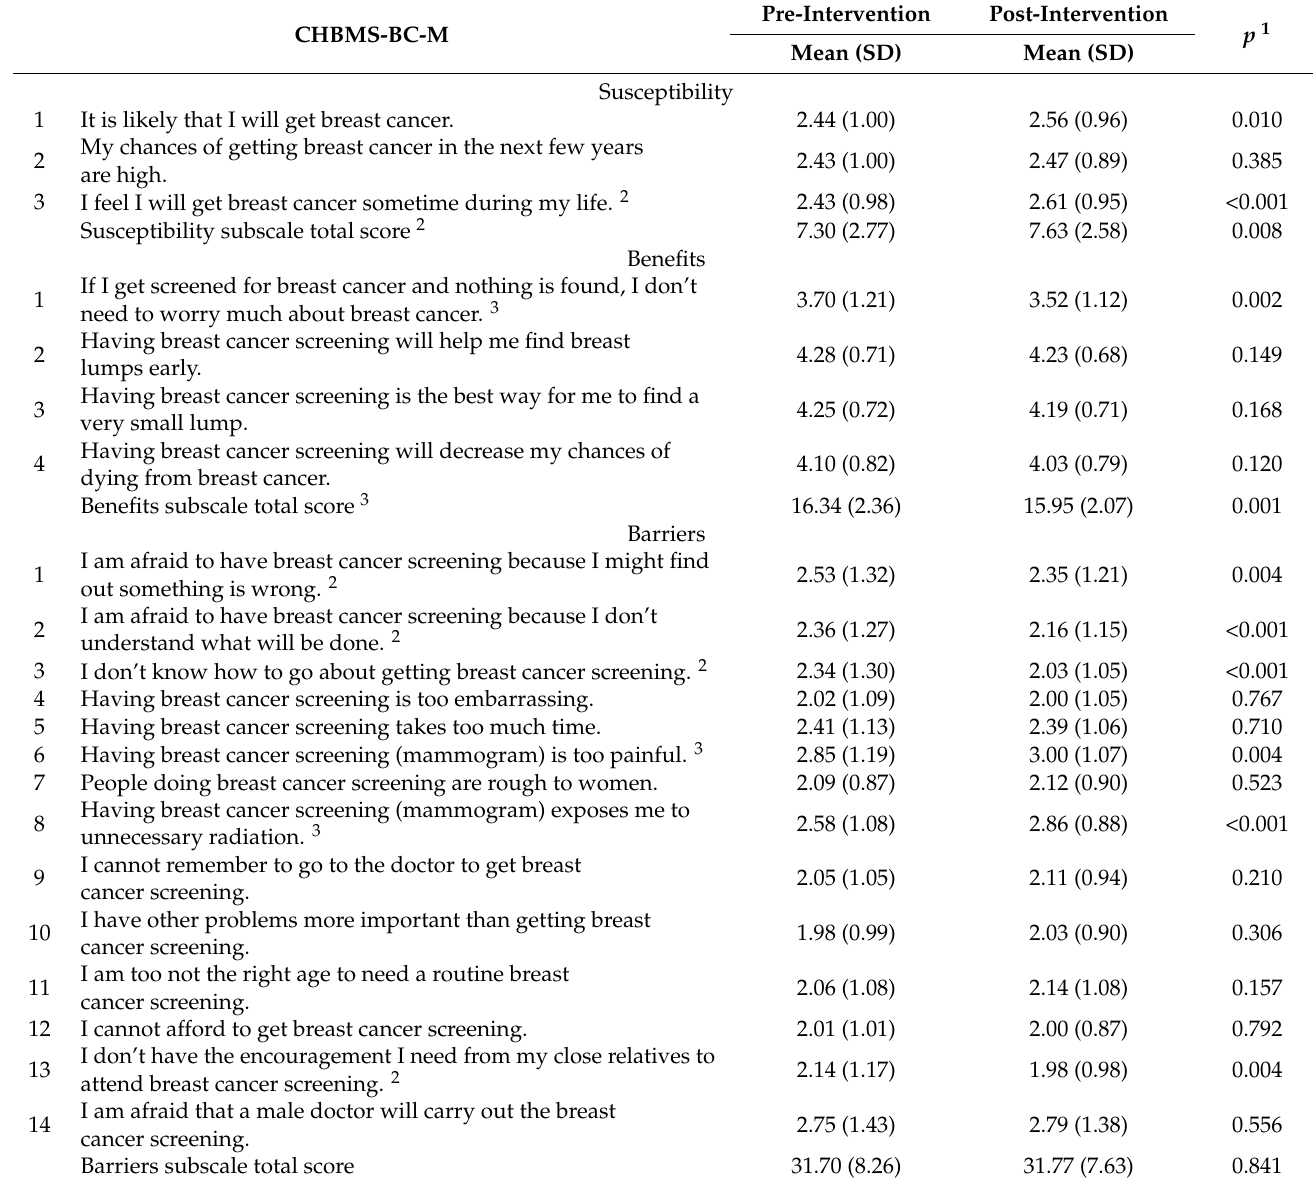
Table 2. Comparison of CHBMS-BC-M mean item and subscale scores pre- and post-BCAC-BC mass media campaign ( n =